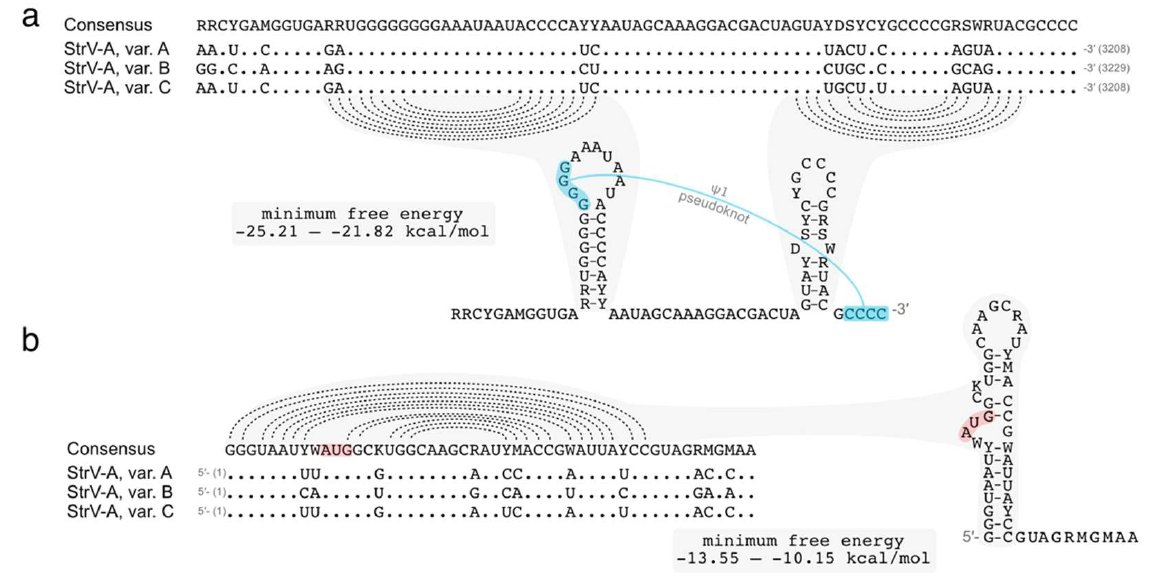
Figure 2. Putative hairpin structures at the termini of the StrVA genome. Multiple alignment and secondary structure of the consensus sequences of the 3′ ( a ) and 5′ ( b ) ends. Dotted lines show predicted pairing. The putative 3′ ψ1 pseudoknot is annotated in blue.